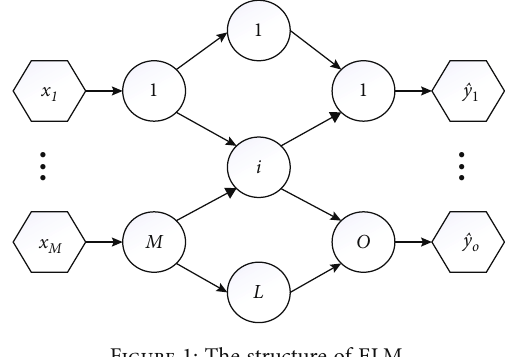
Figure 1: The structure of